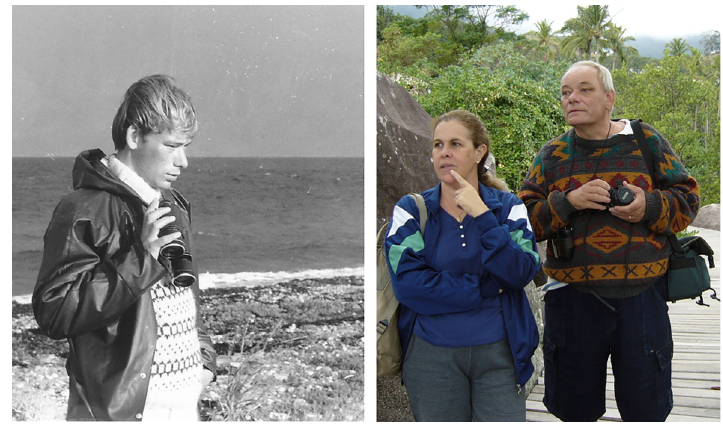
Figure 2. Mogens was a keen ornithologist throughout his life. On the left as a young university student and on the right with his wife